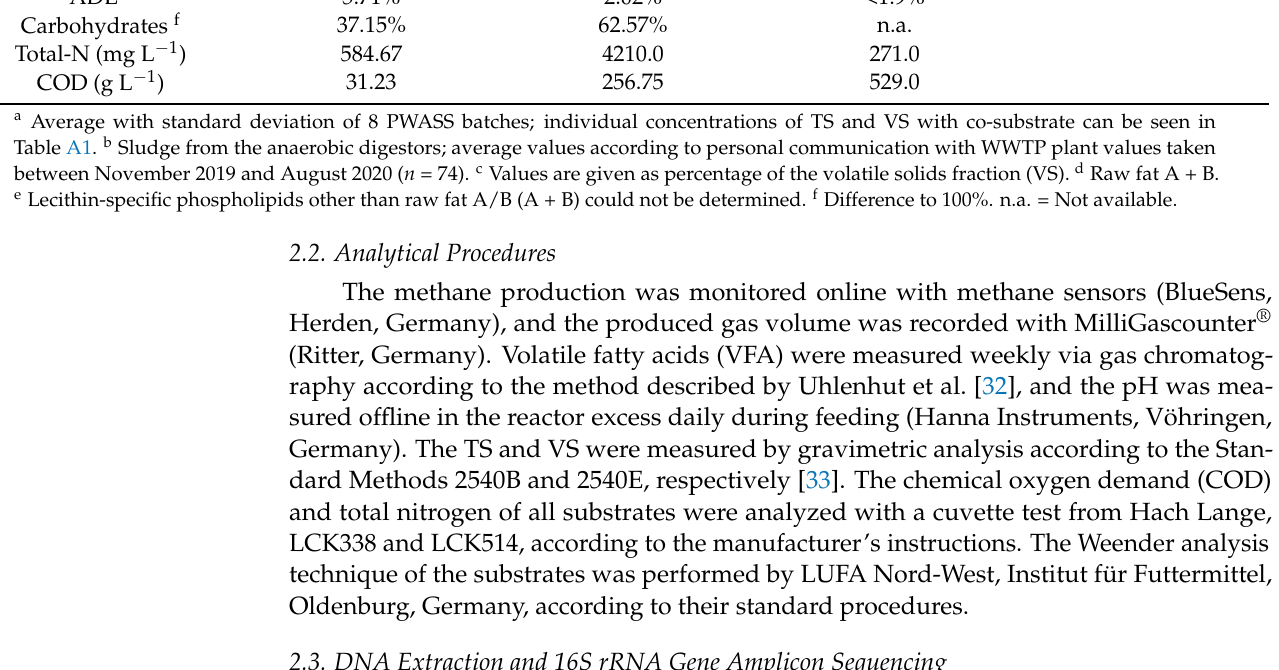
Table A1. b Sludge from the anaerobic digestors; average values according to personal communication with WWTP plant values taken between November 2019 and August 2020 ( n = 74). c Values are given as percentage of the volatile solids fraction (VS). d Raw fat A + B. e Lecithin-specific phospholipids other than raw fat A/B (A + B) could not be determined. f Difference to 100%. n.a. = Not